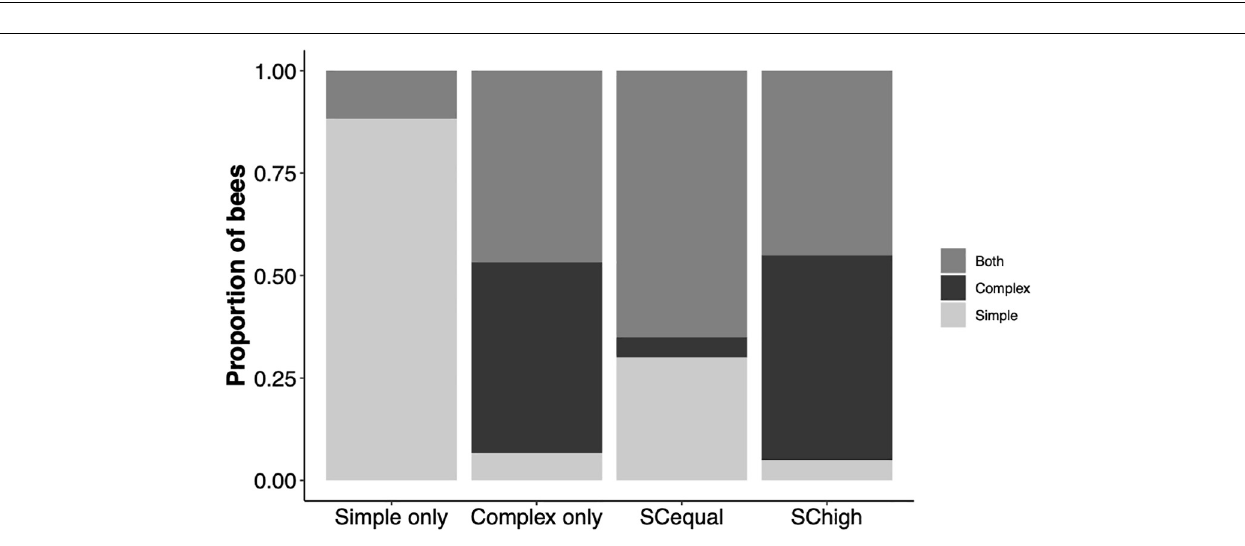
FIGURE 5 | The proportions of bees that specialized on simple flowers, specialized on complex flowers, or showed no flower type specialization during the test phase. Specialized foragers directed > 60% of their visits to one of the flower